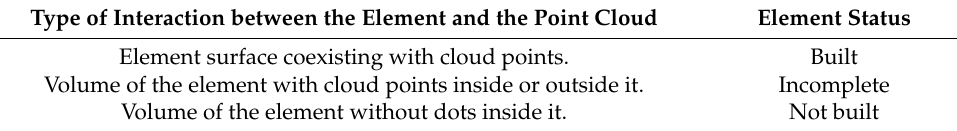
Table 2. Construction status for the elements displayed in the coordination software. Type of Interaction between the Element and the Point Cloud Element surface coexisting with cloud points. Volume of the element with cloud points inside or outside